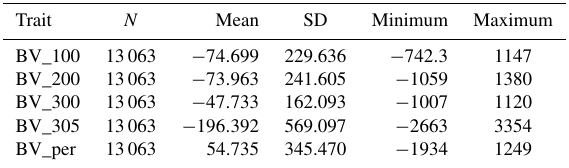
Table 1. Descriptive statistics for BV of lactation persistency and BV of test day milk production (kg).